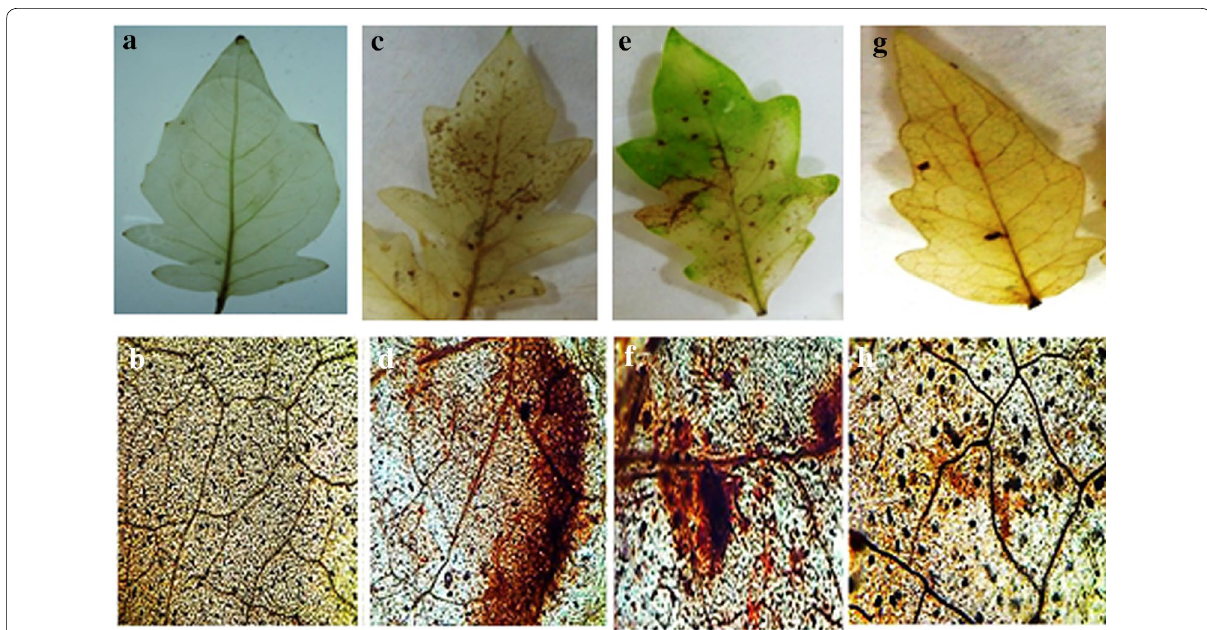
Fig. 1 Localisation of H 2 O 2 in different treatments of tomato leaves as revealed by reddish brown stain. a , b Unchallenged control (control), c , d challenged with pathogen (Fol). e , f Pre-treated with SA and challenge inoculated with pathogen (Fol MeJA and challenge inoculated with pathogen (Fol